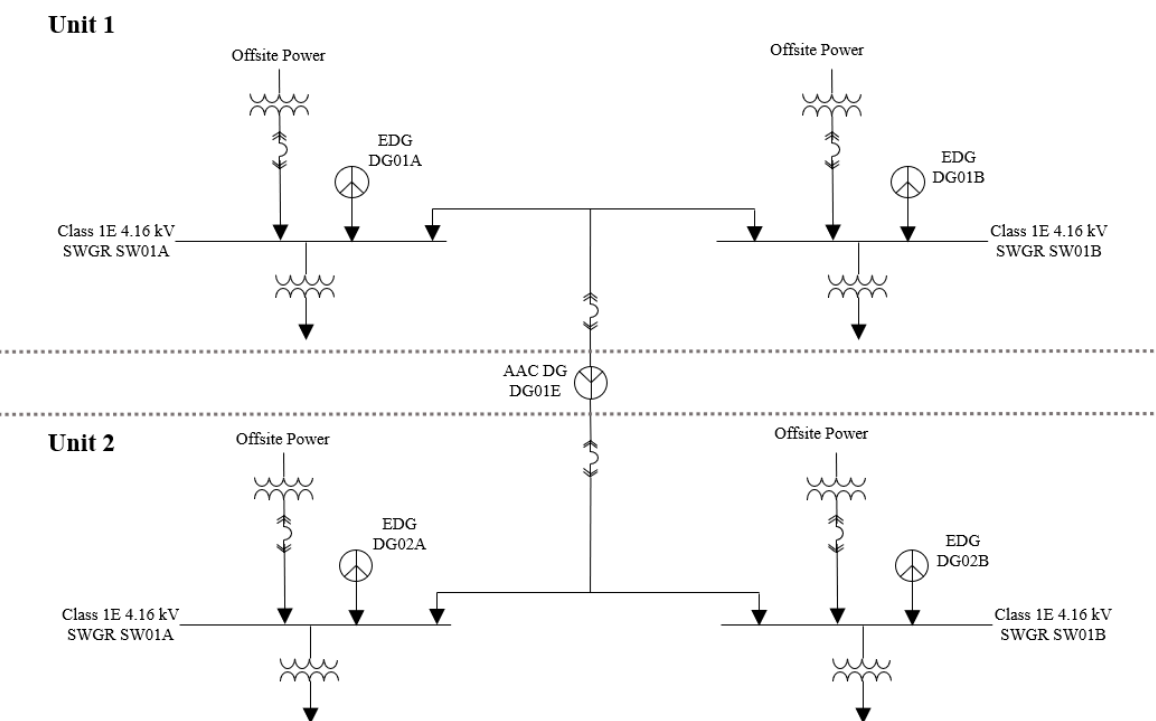
Figure 2. SLD of the EPS for a dual-unit NPP.